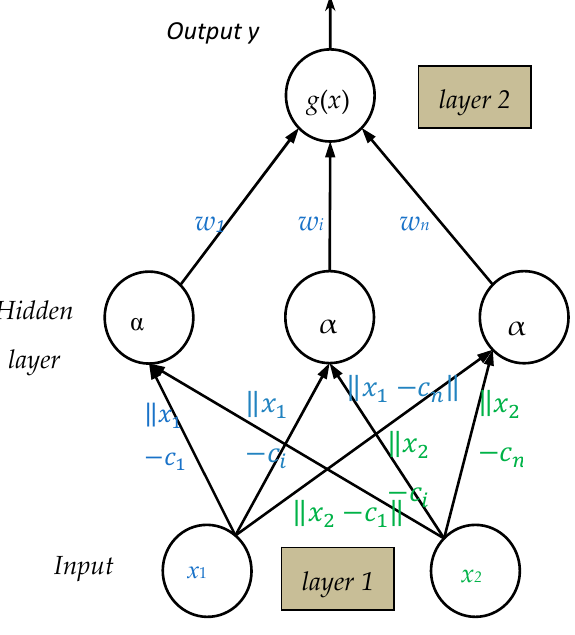
Figure 9. Architecture of ANN.